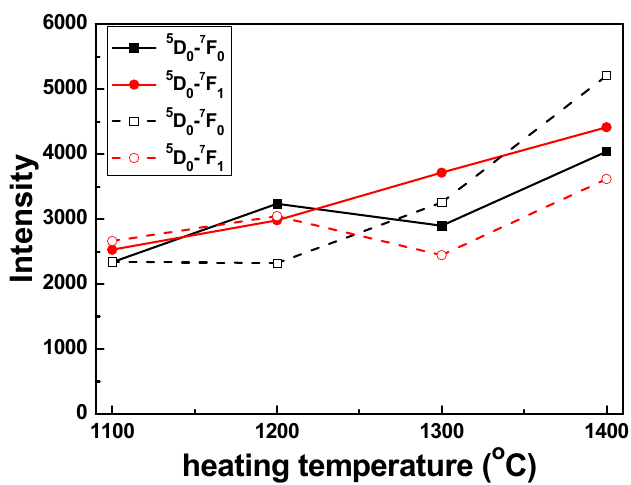
Figure 5. Emission intensity of BaZrO 3 :Eu 0.025 phosphors as a function of heating process and heating temperature. Solid-line: one-step Eu-BZO powders, dashed-line: two-step Eu-BZO powders.